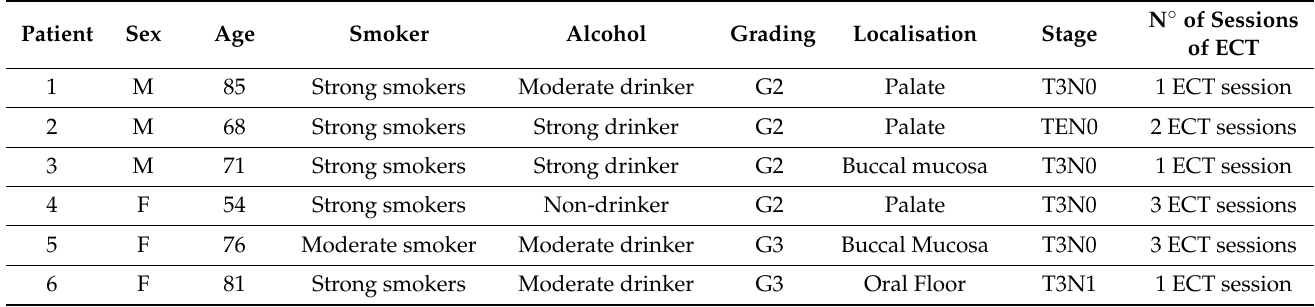
Table 1. Characteristics of the patients and